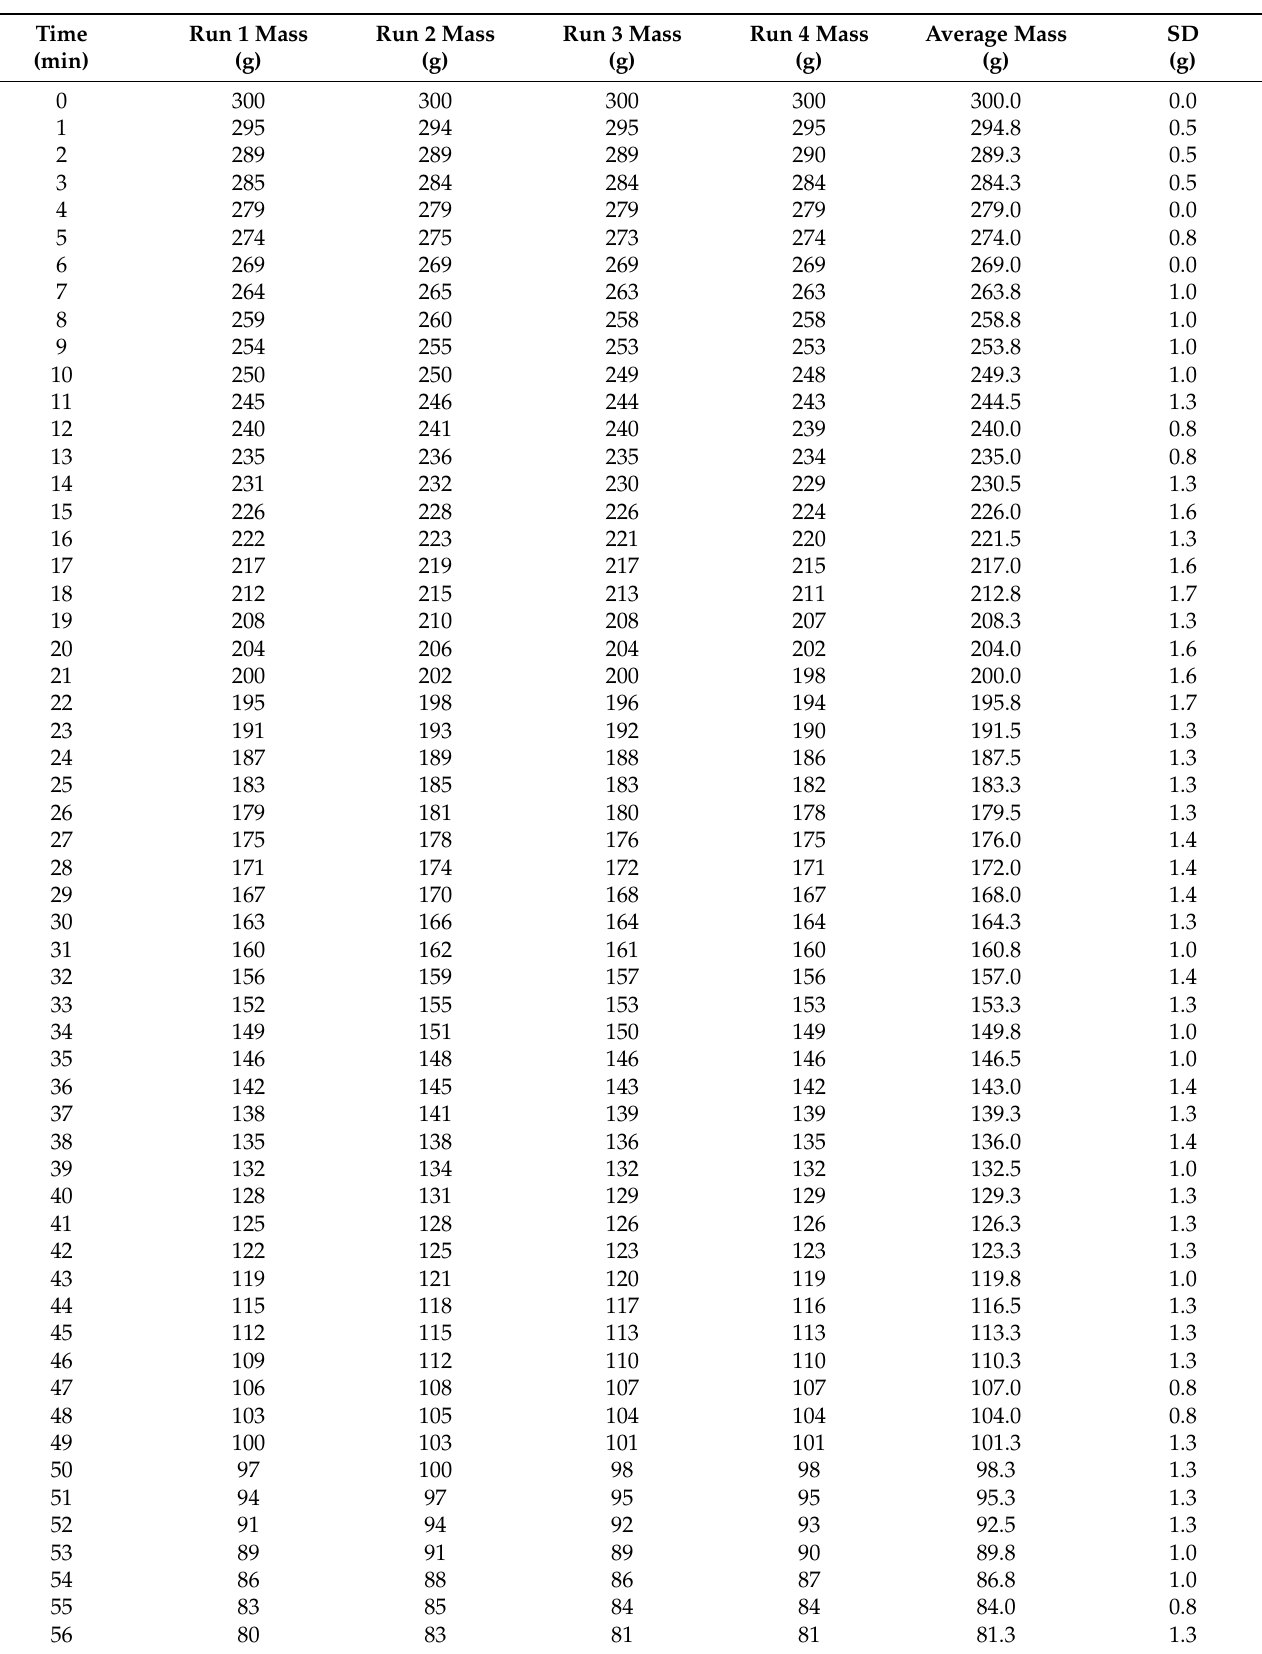
Table A6. Configuration F mass